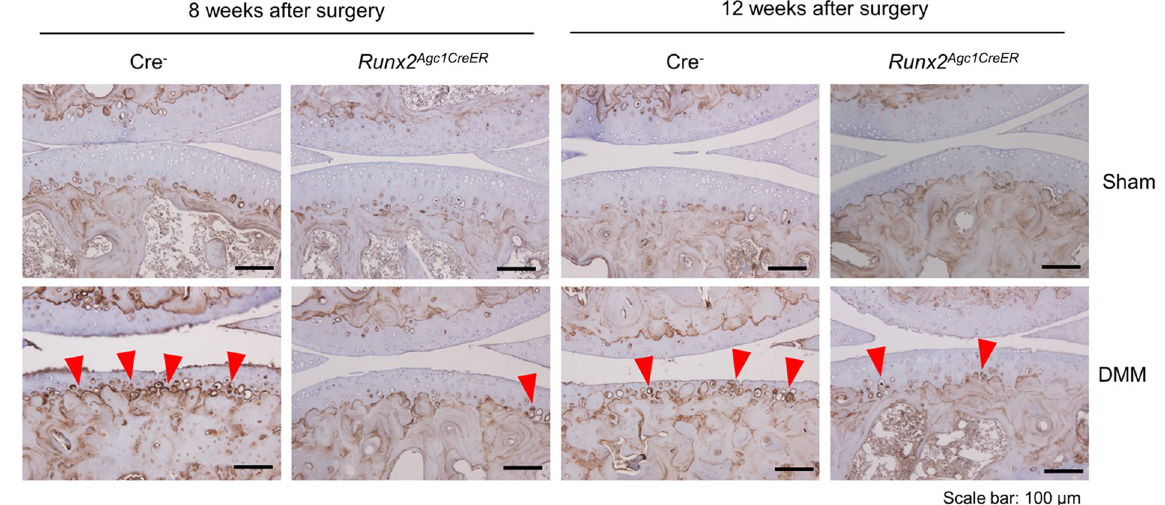
Figure 5. Loss of Runx2 reversed MMP13 up-regulation induced by DMM surgery. DMM surgery and Sham operation was performed in 12-week-old male Cre-negative and Runx2 Agc1CreER KO mice. MMP13 expression was analyzed by IHC assay. Increased MMP13 expression was detected and more MMP13-positive cells were located toward articular surface in Cre-negative control mice 8 and 12-weeks after DMM surgery (MMP13- positive cells: red arrowheads). Deletion of Runx2 significantly down-regulated MMP13 up-regulation induced by DMM (scale bar = 100 μ